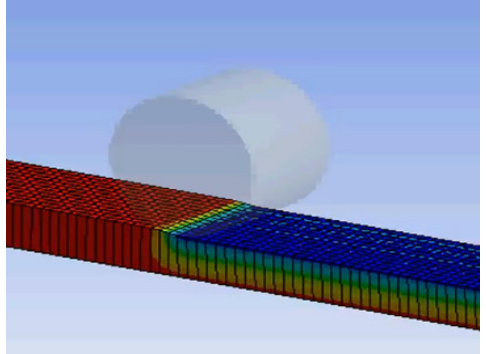
Figure 7. 1/4 size hot rolling simulator.